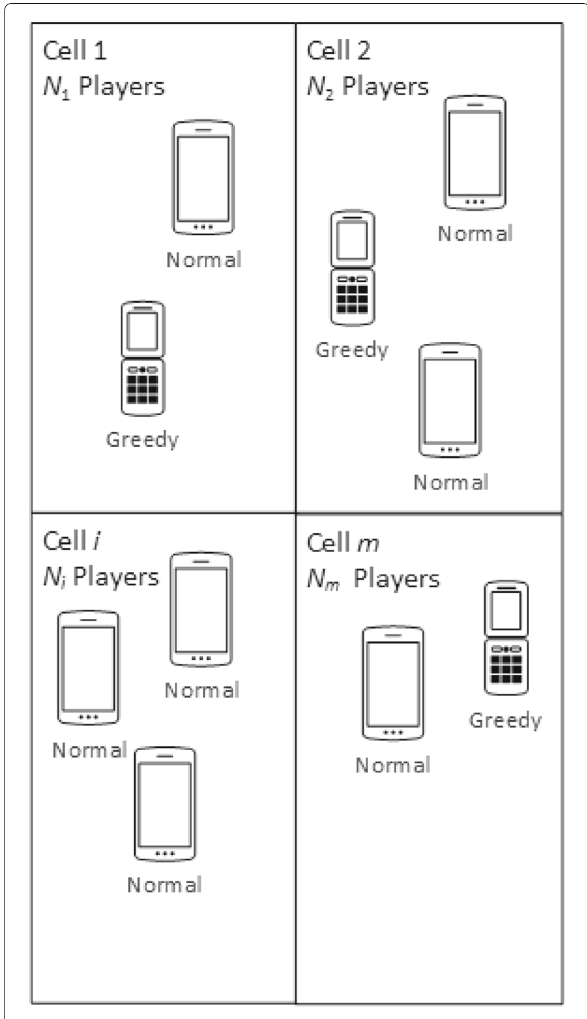
Fig. 2 Cognitive network with M players can be divided into m cells each with N; players a basic utility function for the greedy player that needs to be minimized,